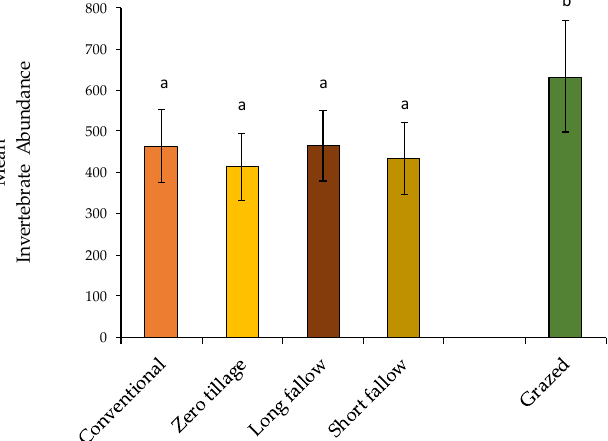
Figure 3. Variations in mean total invertebrate abundance (mean total per field) under tillage, fallow regimes under cropping land use type and grazing land use type over study period. Each data point was the total abundance of 20 pitfall traps per field, with each field (n = 24) sampled eight times (once per season) over two years. The mean for a specific treatment was based on the number of replicates for that particular grouping i.e., grazing (n = 64) or cropping (n = 128). Total number of sampling occasions = 192. Bars signify ± SEM.